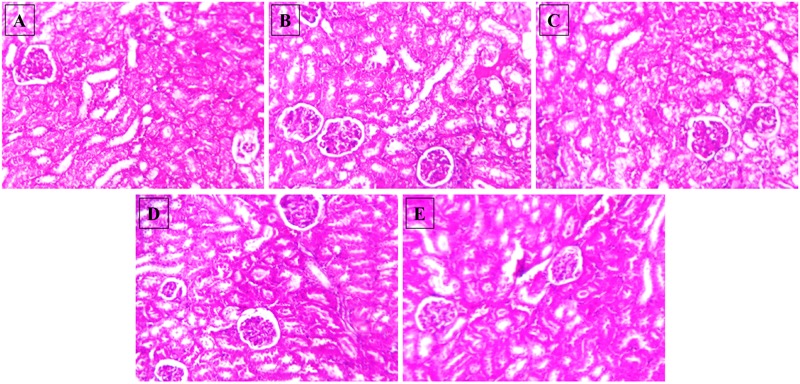
Effect of NAT-1 and NAT-2 on morphological feature of mice kidney. Optical microscopy: H&E (200×). Photomicrographs of representative mice are shown. (A) Normal control; (B) HSD fed control; (C) HSD fed mice treated with metformin; (D) HSD fed mice treated with NAT-1; (E) HSD fed mice treated with NAT-2.